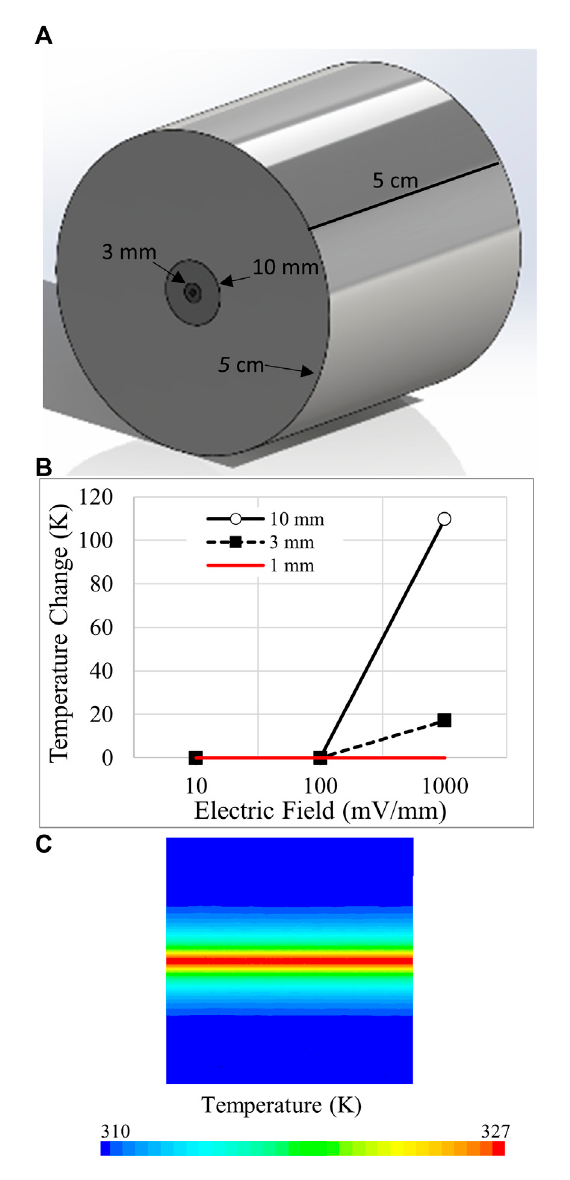
FIGURE 7 Modeling of temperature changes due to electrokinetic perfusion through narrow channels. (A) Ohmic heating during electrokinetic perfusion was constrained to small cylindrical regions of 1, 3, and 10 mm diameter and allowed to dissipate into a larger 5 cm diameter cylinder with thermal conductivity of (cid:129) 0.21 W/(m K) to match cartilage. The length of the cylinder is also 5 cm. (B) Summary of the peak steady state heat for three regions of different diameter at 10, 100, and 1,000 mV/mm. DC current fl ow begins to generate damaging heat above 100 mV/mm. (C) Pseudo-colored heat map of the 3 mm cylinder at 1,000 mV/mm. The core of the cylinder reaches just above 327 K at steady